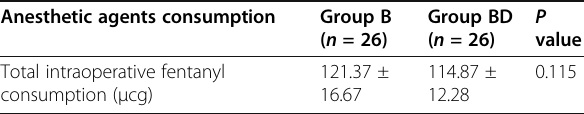
Table 5 Intraoperative fentanyl consumption Anesthetic agents consumption